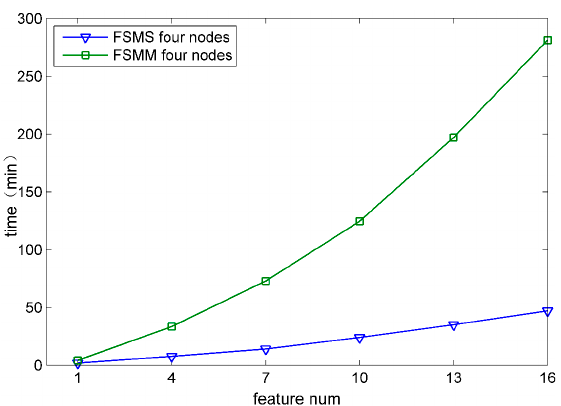
Figure 5. Four nodes process Data6.